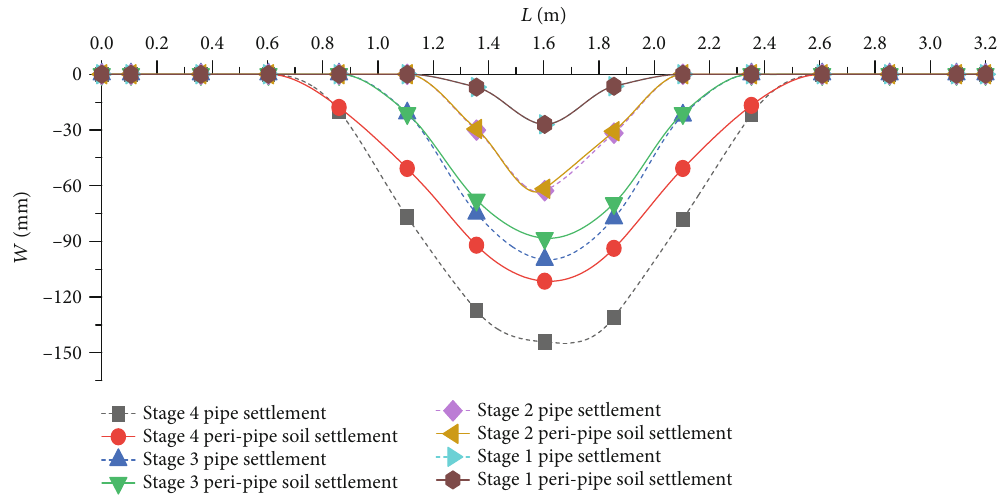
Figure 7: Deformation and evolution of pipe-soil during the development of